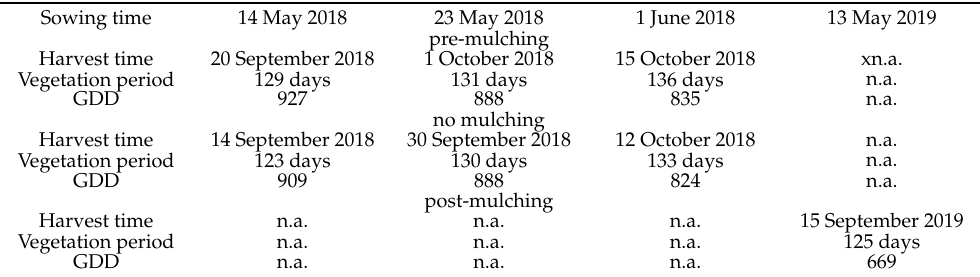
Table 2. Vegetation period parameters (sowing and harvesting dates and growing degree days (GDD)) for vegetable soybean grown in Norway in 2018 and 2019. Base temperature 10 ◦ C was used in GDD calculation. Sowing